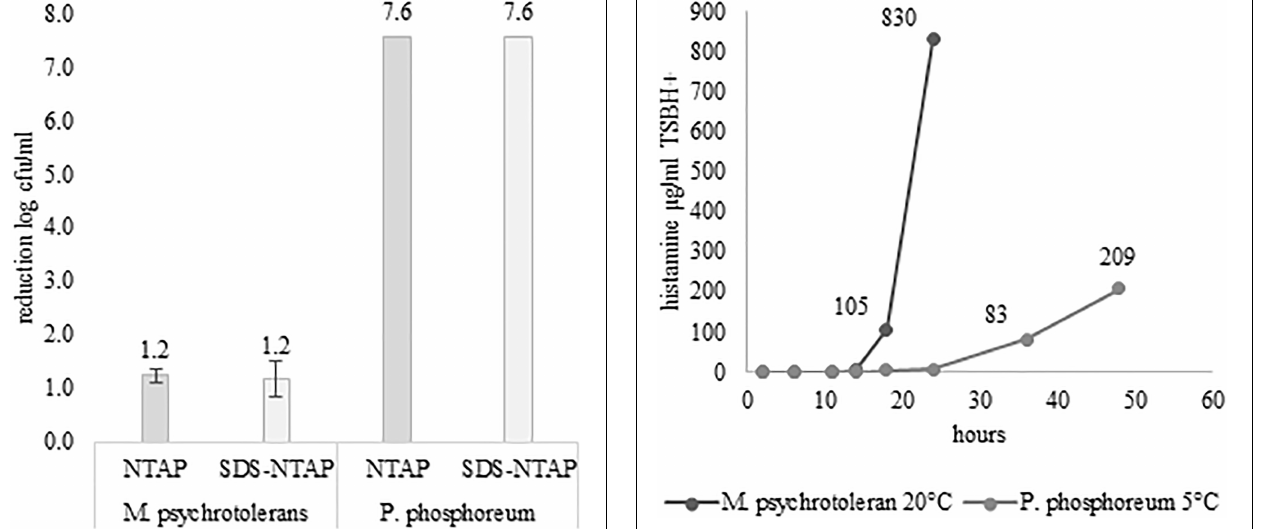
FIGURE 1 | Effect of Not-Thermal Atmospheric Plasma and SDS (0.05% w/v) on M. psychrotolerans and P. phosphoreum . Counts after incubation at 2–4 ◦ C for 7 days.